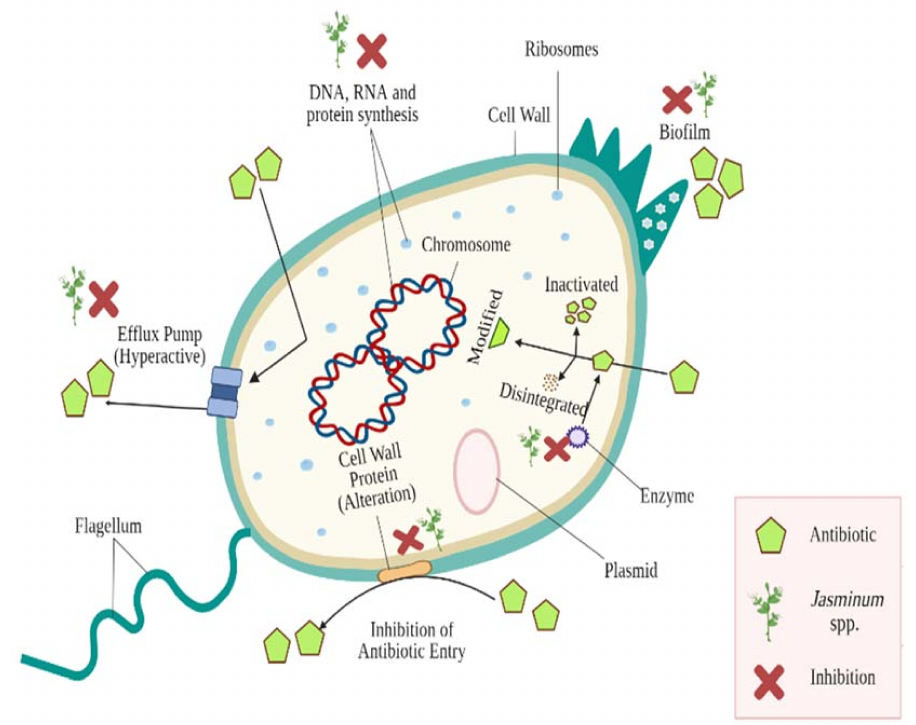
Figure 2. Major antibiotic resistance mechanisms evolved among bacterial strains and impact of Jasminum spp. against them (Created using